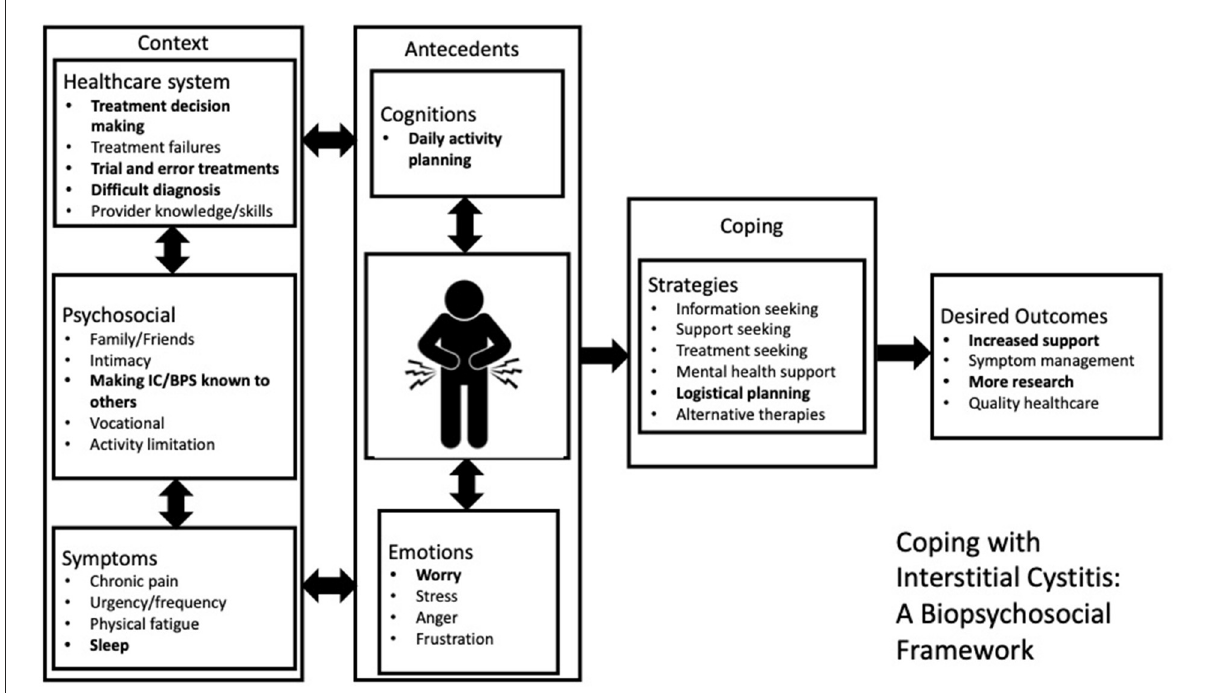
FIGURE1 Biopsychosocial conceptualization of men’s experience with interstitial cystitis.